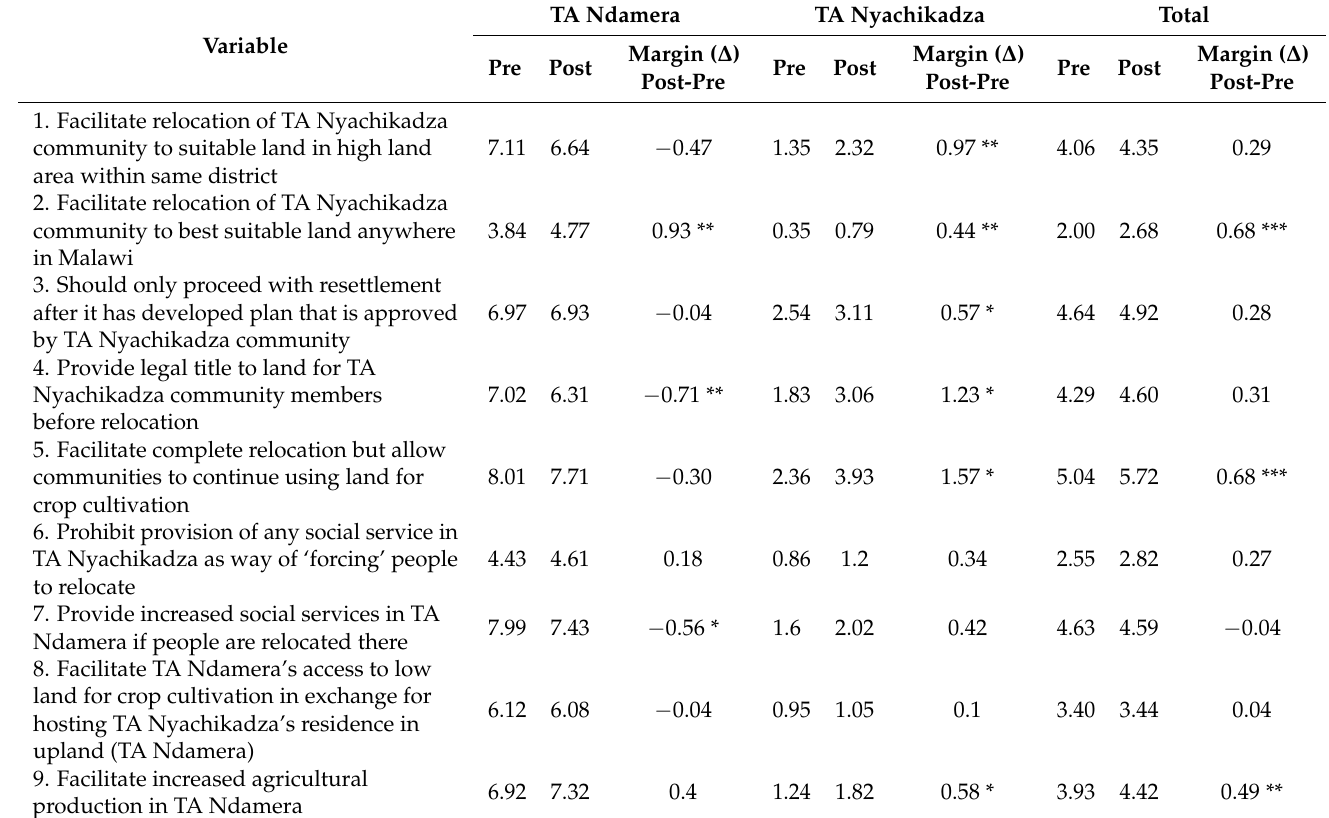
Table 2. What the government should do regarding relocation and